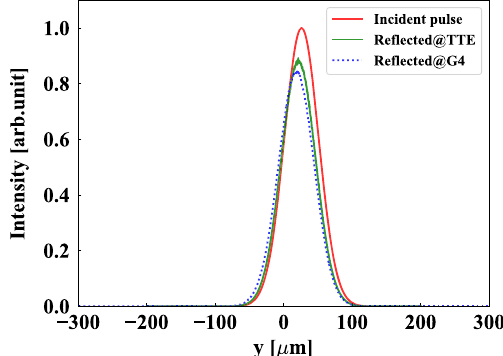
FIG. 4. A benchmark of the GEANT 4 (G4) reflection process. The G4 results are compared to those of solving two-dimensional Takagi – Taupin equations (TTE). The reflected intensity profiles of the two cases have a reasonable difference, while the incident pulses have the same profile. The G4 simulation and the TTE calculation use an RMS transverse size of 25 μ m.